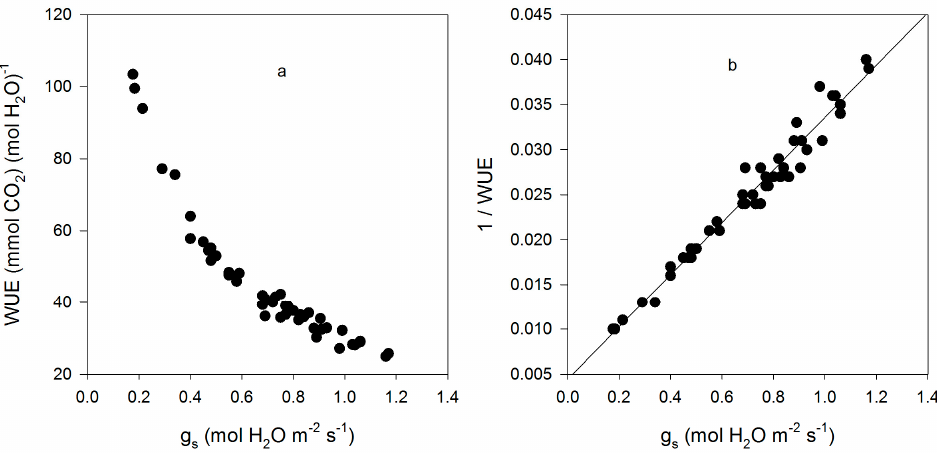
Figure 1. Leaf intrinsic water use efficiency (WUE) ( a ); and the reciprocal of leaf intrinsic WUE ( b ) as a function of stomatal conductance (g s ) for all measurements made on fifteen cultivars of soybean. The linear regression of (1/WUE) = 0.0044 + 0.029 × g s had an r 2 value of 0.965.